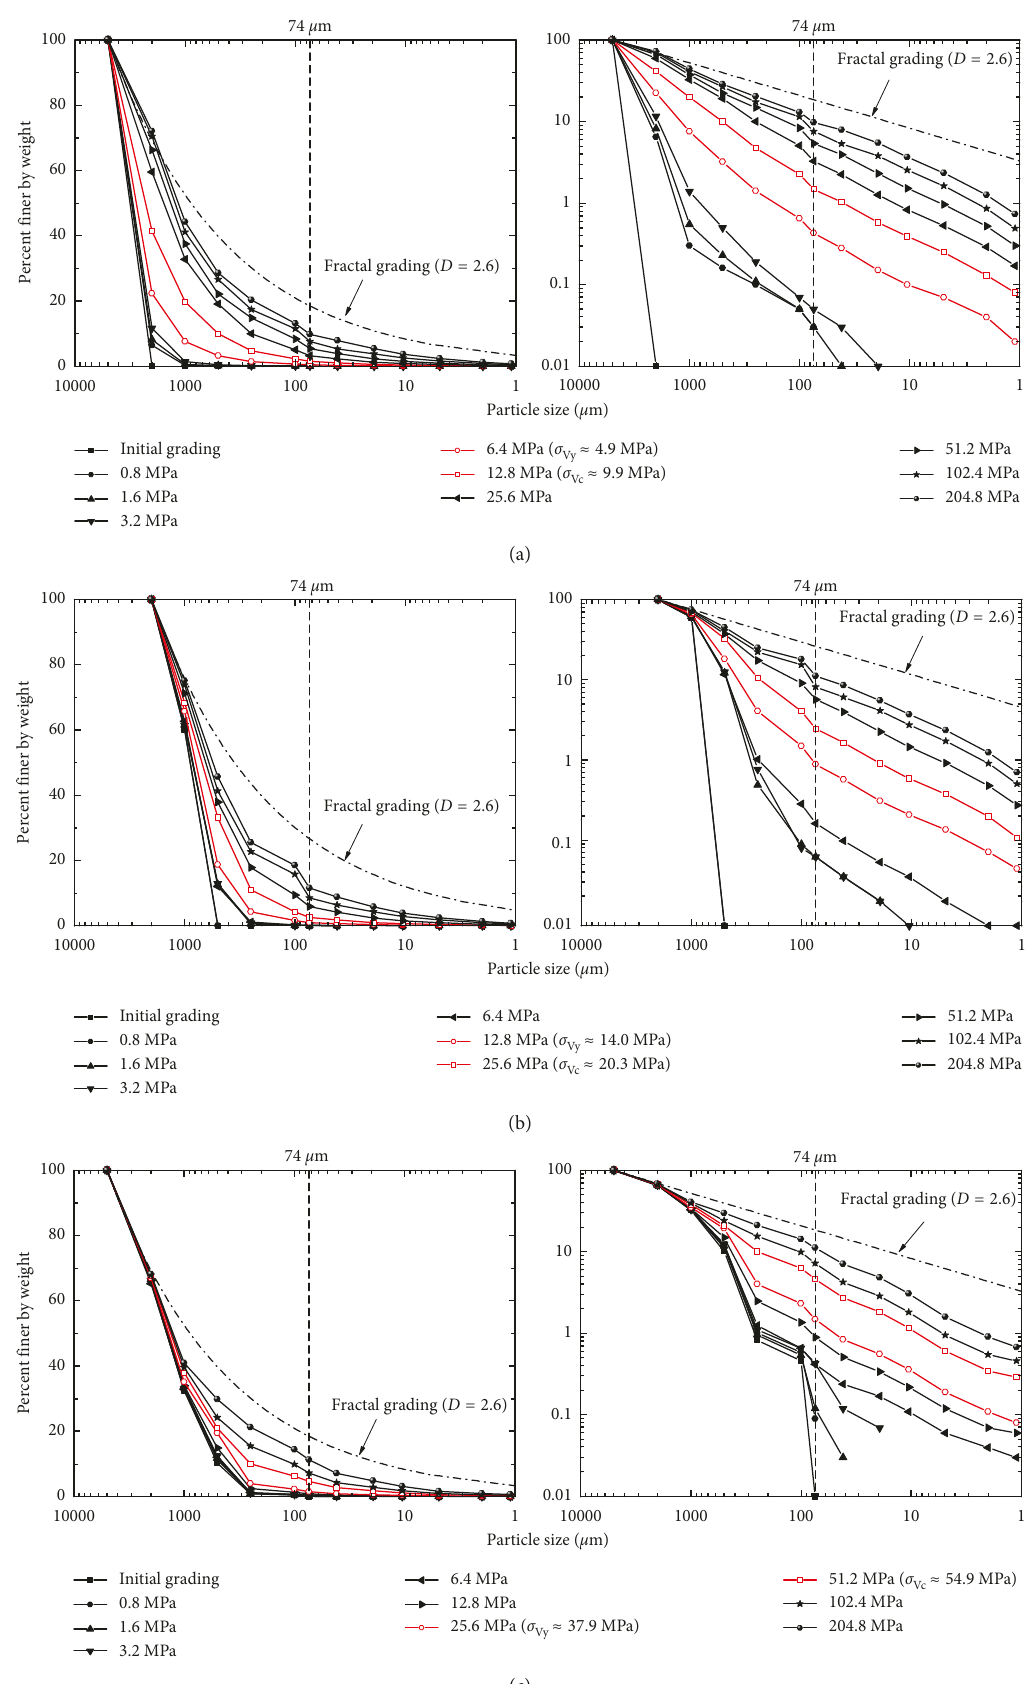
Figure 5: Grading curves after tests terminated at each preset stress level for (a) QS1, (b) QS2, and (c)